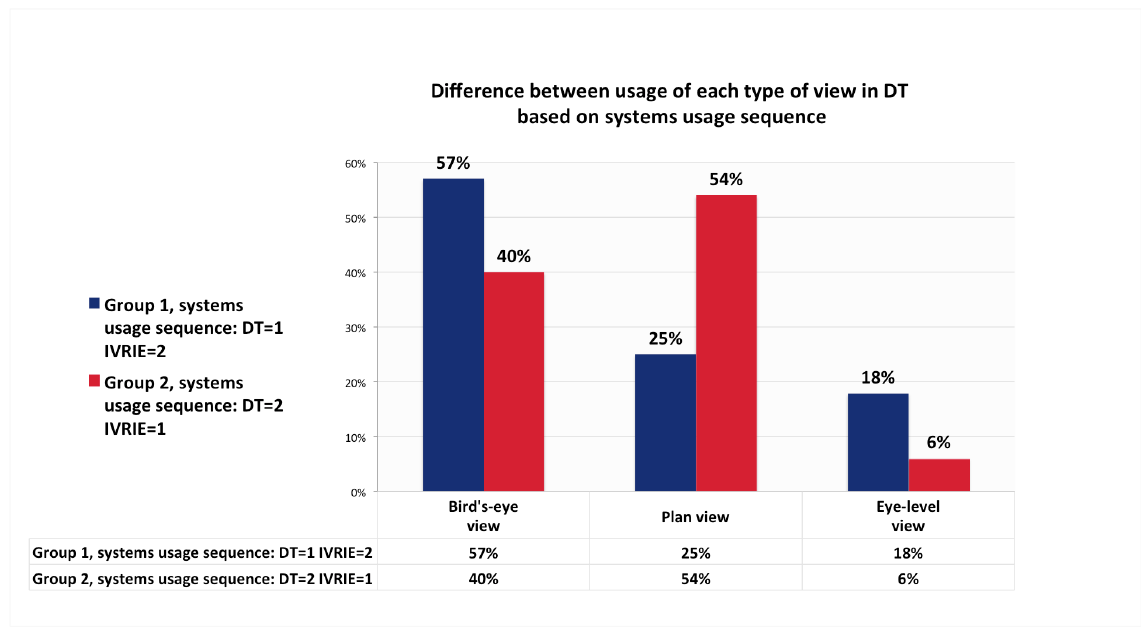
Figure 6. Comparison of view usage patterns in the DT system as impacted by variations in system usage sequence.